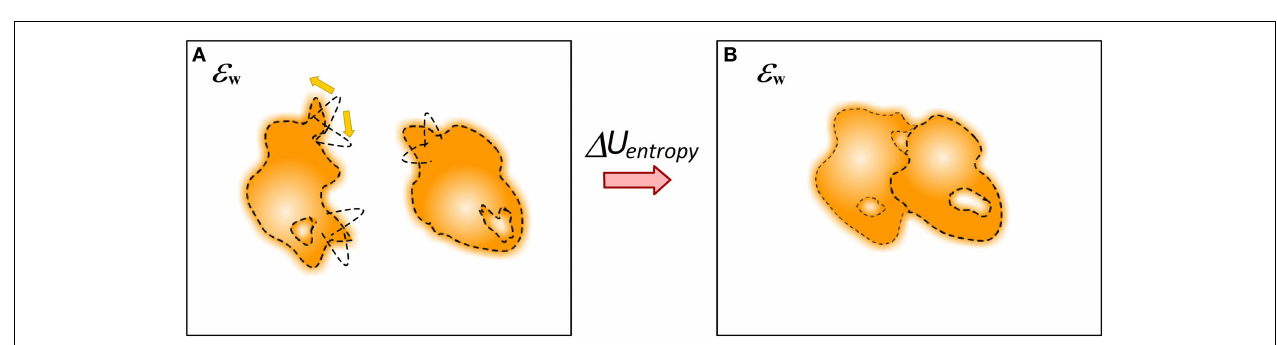
internal mechanical energy (caused by different bond angles and lengths). The internal structure changes are represented in dark red lines.